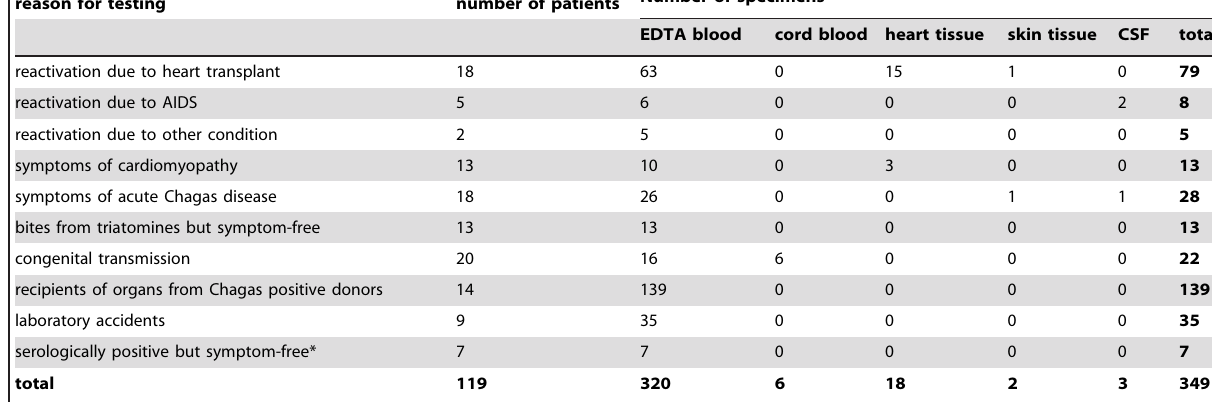
Table 1. Specimens included in this